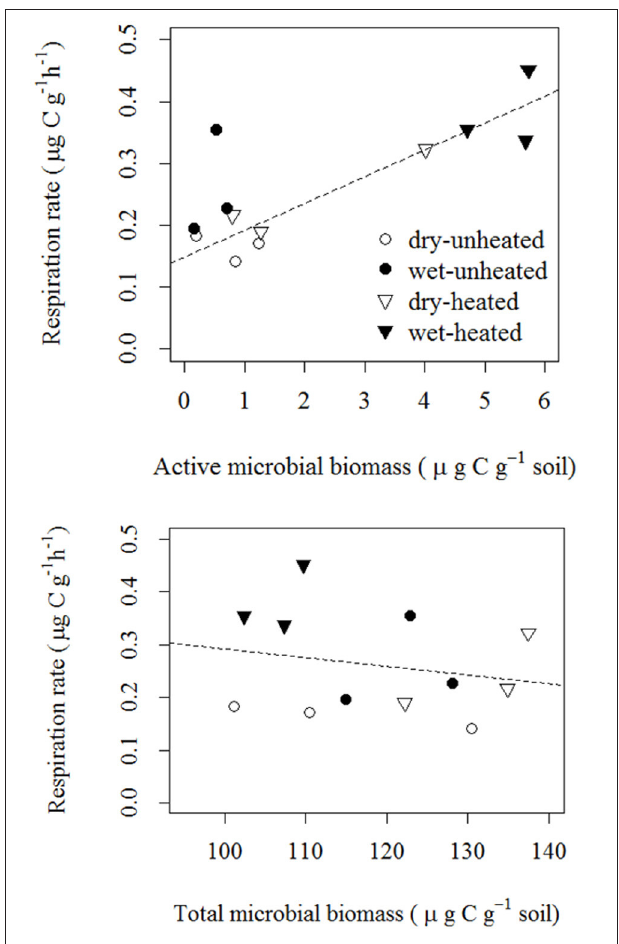
FIGURE 5 | Correlations of soil basal respiration with active microbial biomass [top; F (1 , 11) = 15.97, p = 0.003 R 2 = 0.62; statistics were calculated using log 10 -transformed AMB] and total microbial biomass [bottom; F (1 , 11) = 0.47, p = 0.509, R 2 = 0.04